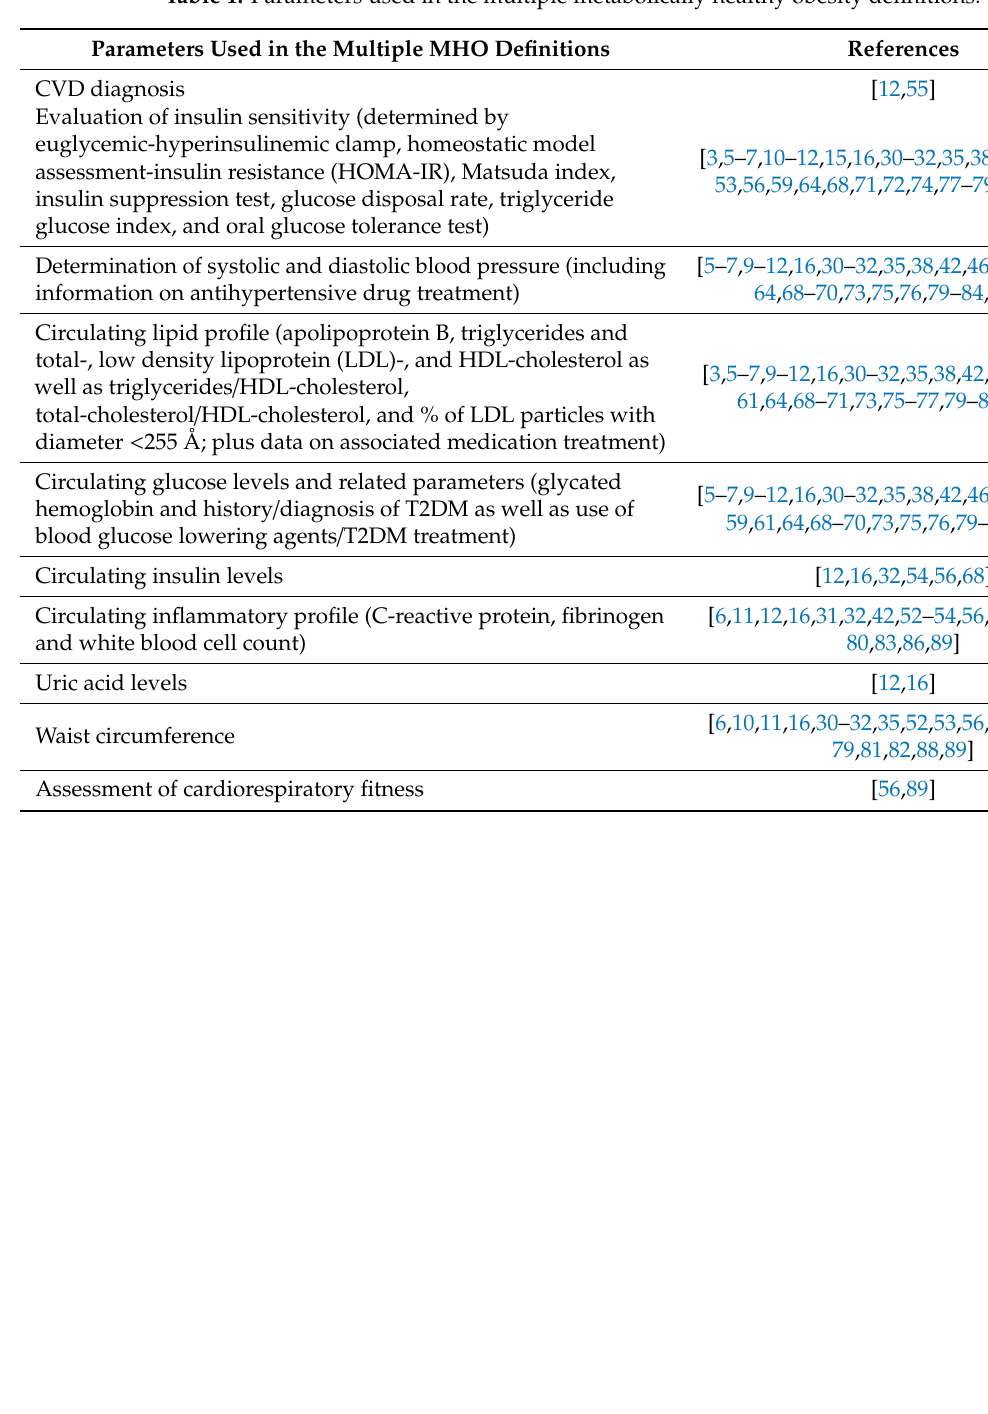
Table 1. Parameters used in the multiple metabolically healthy obesity